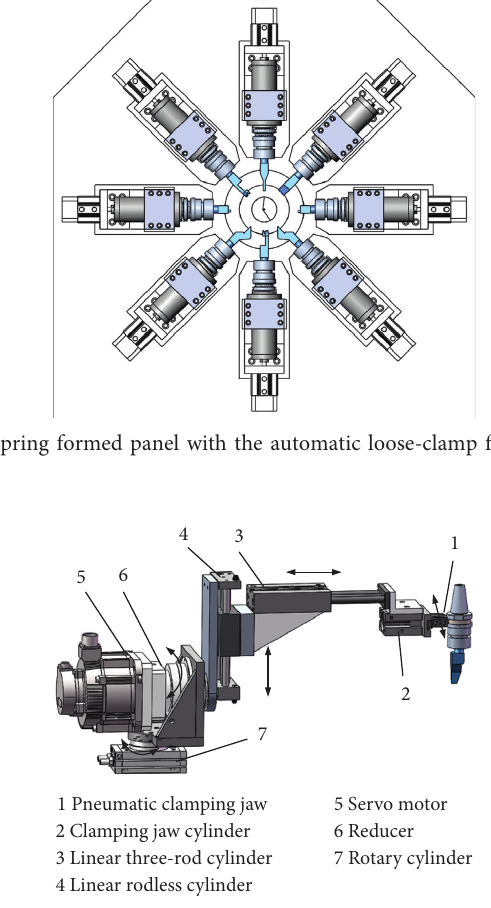
Figure 6: Structure of the automatic tool change arm.